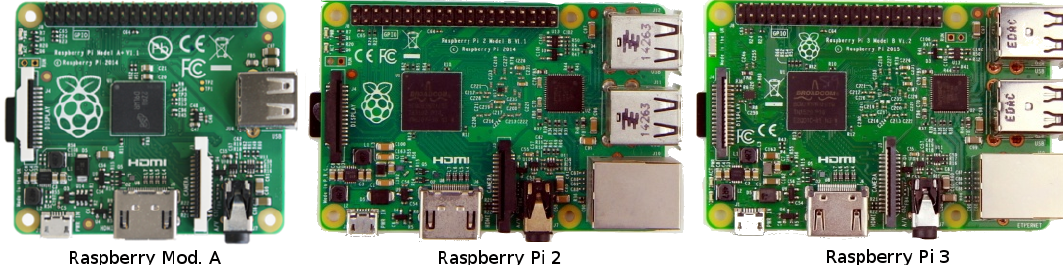
Figure 13. Overview of different Raspberry Pi